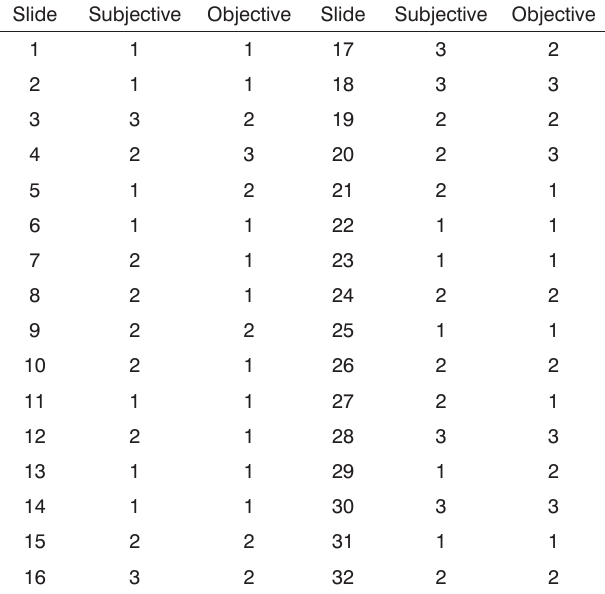
Table 3. Comparison between subjective and objective assessments of cases in group 1.